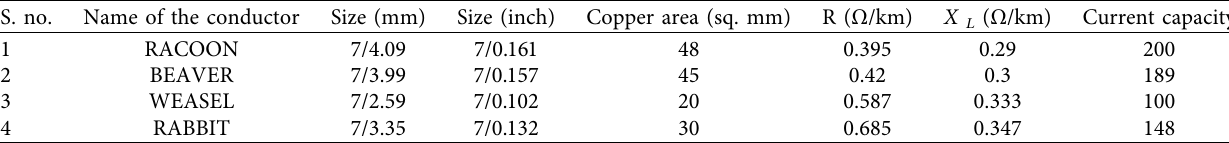
Table 1: Technical specifcation of diferent types of conductors.